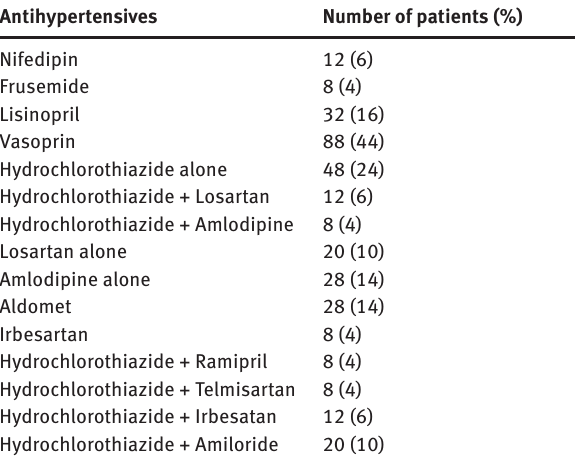
Table 2: Distribution of Patients Receiving Antihypertensive Therapy. All participating hypertensive patients were receiving antihypertensive therapy either singly or in combination. The majority (88) (44%) were receiving Vasoprin, followed by 48 (24%) on hydrochlorothiazide alone.